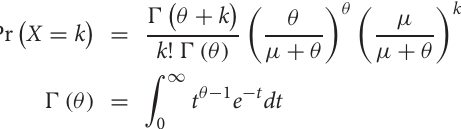
expectation µ (mean) and size parameter θ